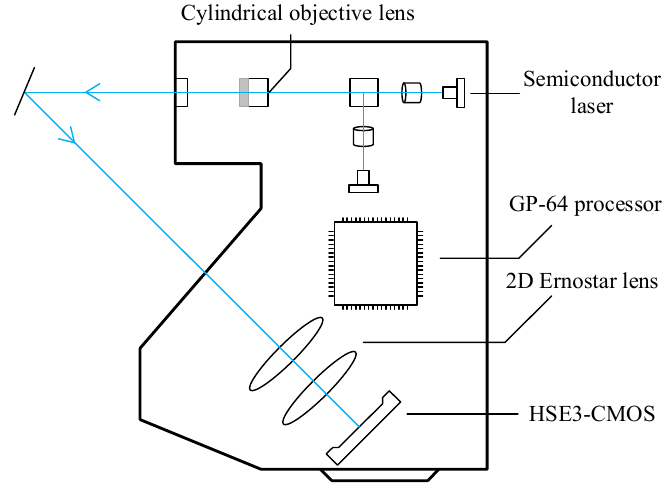
Figure 3. The configuration of our laser sensor.